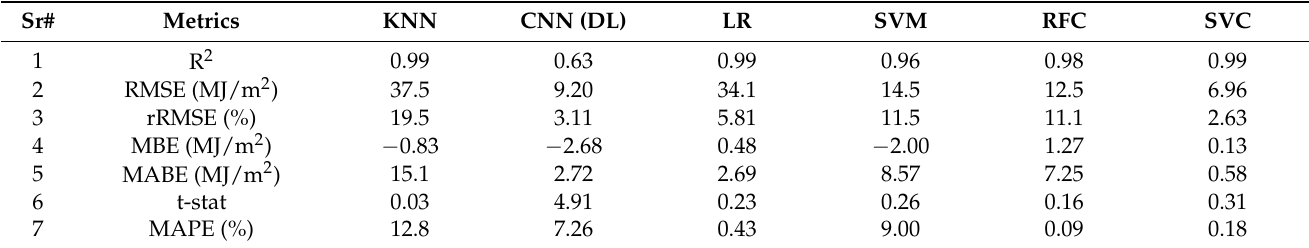
Table 3. Statistical metrics evaluation for all the algorithms in Najran province.